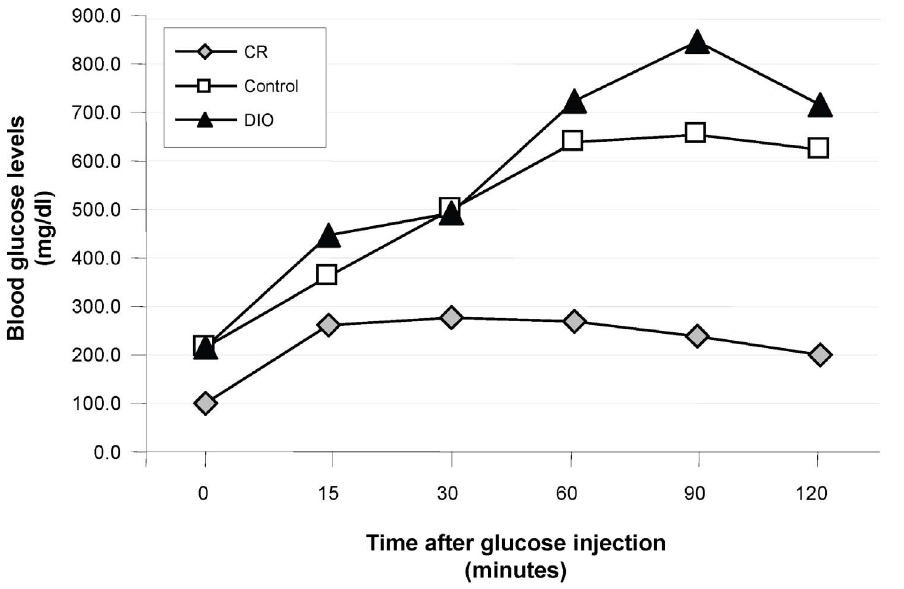
Figure 2. Glucose tolerance testing in CR, control, and DIO mice after ten weeks on dietary treatment. Each data point represents the mean of ten mice per dietary treatment.